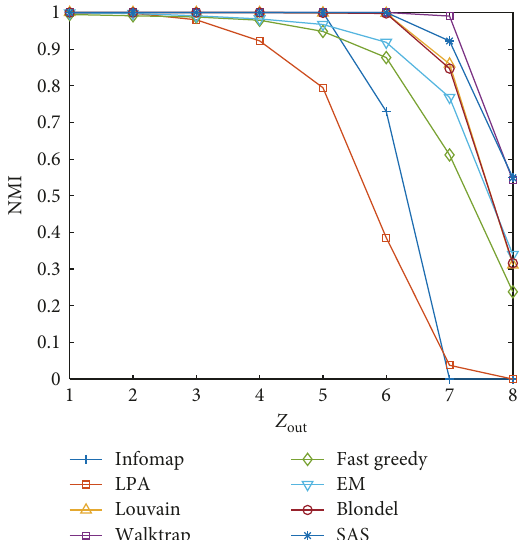
Figure 7: Community detection on GN networks. For each combination of parameters, 100 networks have been generated. And for each network, the community detection methods Infomap, LPA, Louvain, Walktrap, Fast greedy, EM, and Blondel have been executed. The communities detected have been compared by computing the normalized mutual information (NMI). The parameters β � 3, c � 0 . 9, and ρ � 0 .